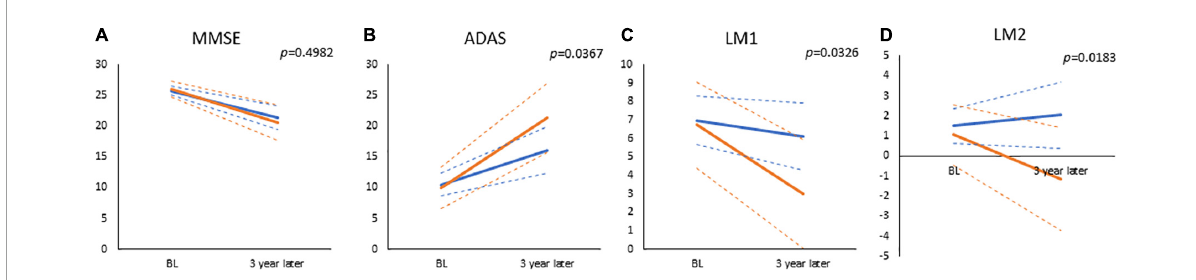
FIGURE4 The results of general mixed linear models, which estimated values at baseline and visit of 3-year follow-up for (A) Mini-Mental State Examination (MMSE), (B) Alzheimer’s Disease Assessment Scale-Cognitive Component-Japanese version (ADAS), (C) Wechsler Memory Scale-Revised, logical memory I (LM1), and (D) Wechsler Memory Scale-Revised, logical memory II (LM2). Displayed p -values are significant for the interaction of time and education (high or low cognitive reserve). The solid and dashed lines connect the mean and 95% confidence interval at baseline and 3 years, respectively. Blue lines: low-education group (years of school education ≤ 12); Red lines: high-education group (years of school education ≥ 13).